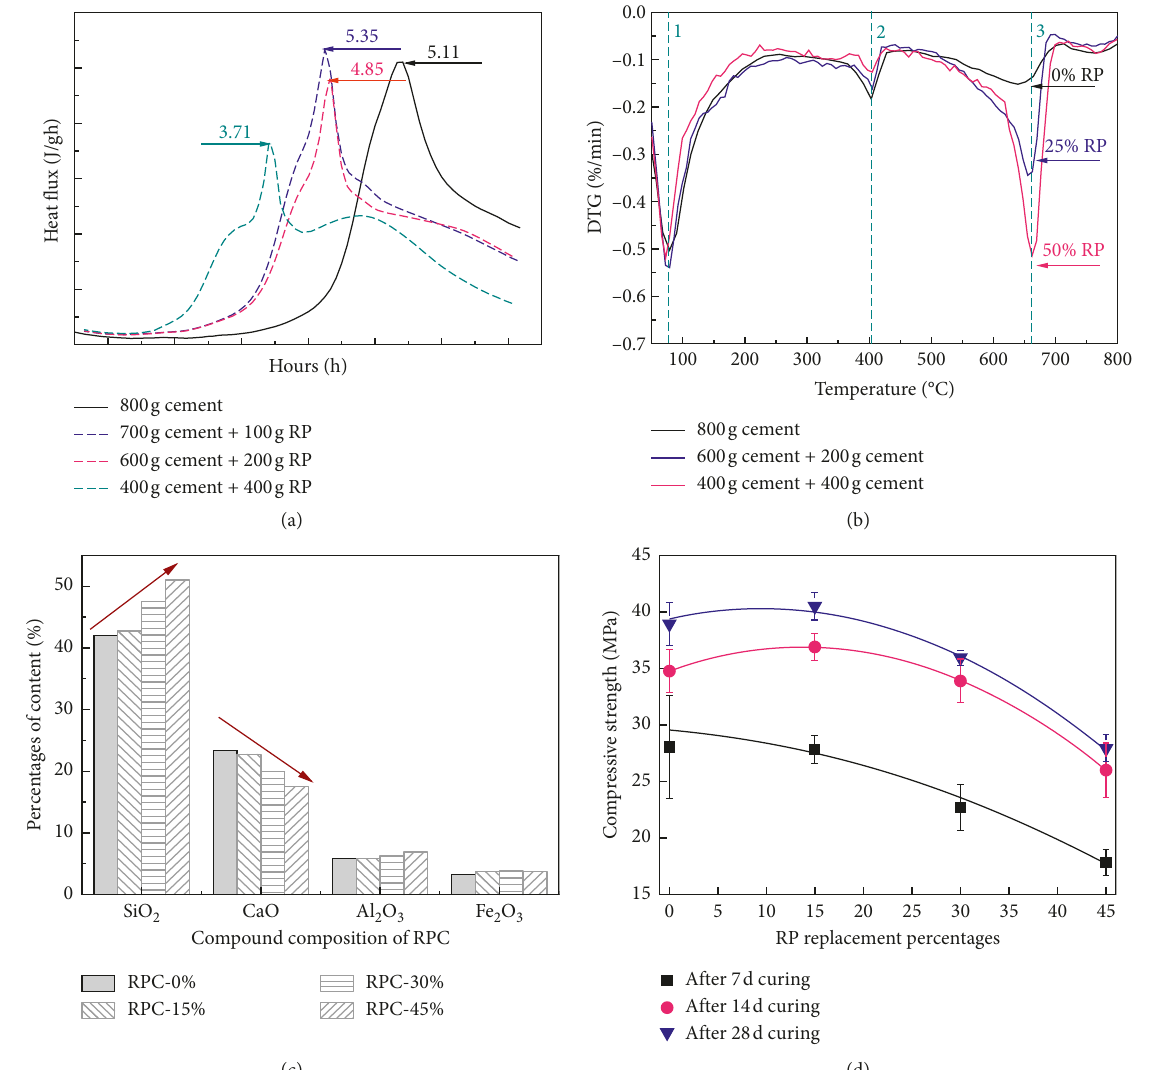
Figure 4: Properties of concrete with various amounts of RP content. (a) The hydration heat curve of the cement and RP mixture. (b) The thermogravimetric test result of the cement and RP mixture. (c) The compound composition of RPC. (d) The compressive strength of